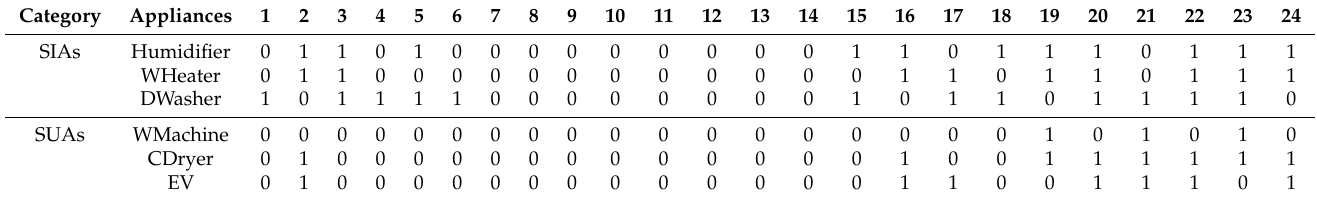
Table 5. Consumer schedules when participating in a DR